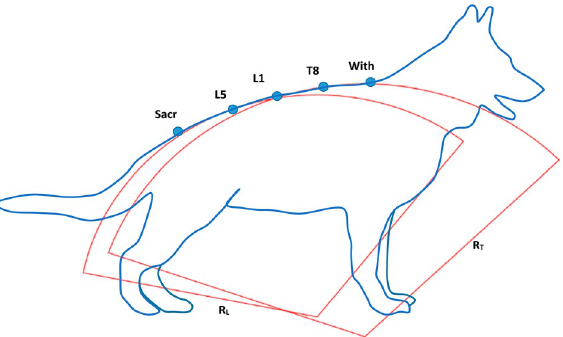
Figure 3. Illustration of the calculation of the radius of curvature of the thoracic (R T ) and lumbar (R L ) regions of the back using the location of the markers along the back (Sacr: sacrum, L5: lumbar 5, L1: lumbar 1, T8: thoracic 8, Wit: withers). Expressed in metres